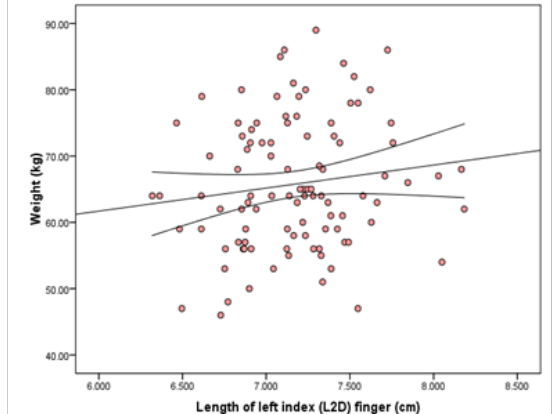
Fig 5. Correlation of length of right index finger (R2D) with weight